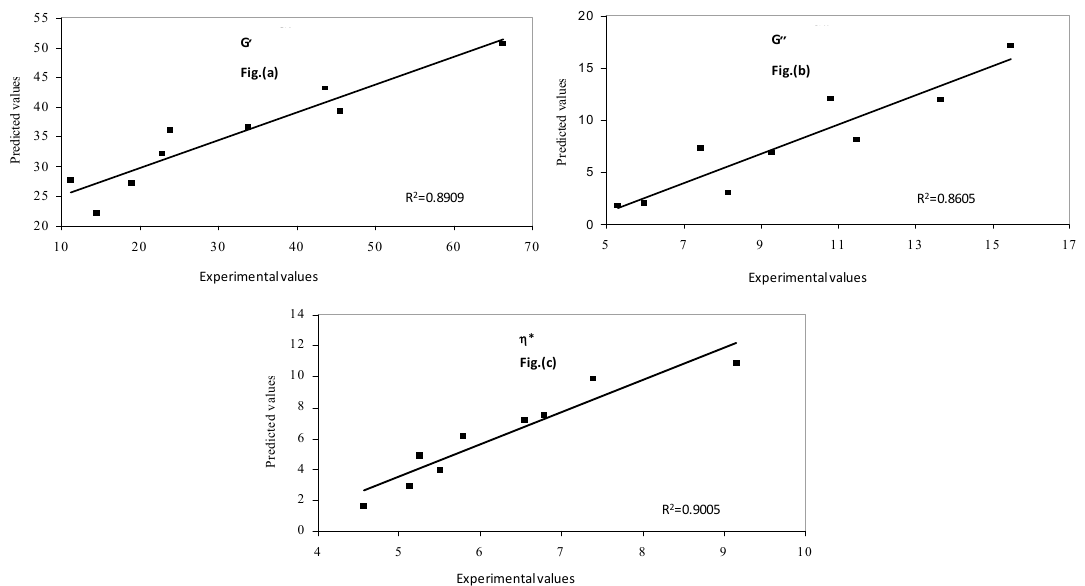
Figure 9. Predicted and experimental values of ( a ) elastic modulus ( b ) viscous modulus and ( c ) complex viscosity at 500 MPa and 3 min holding time.